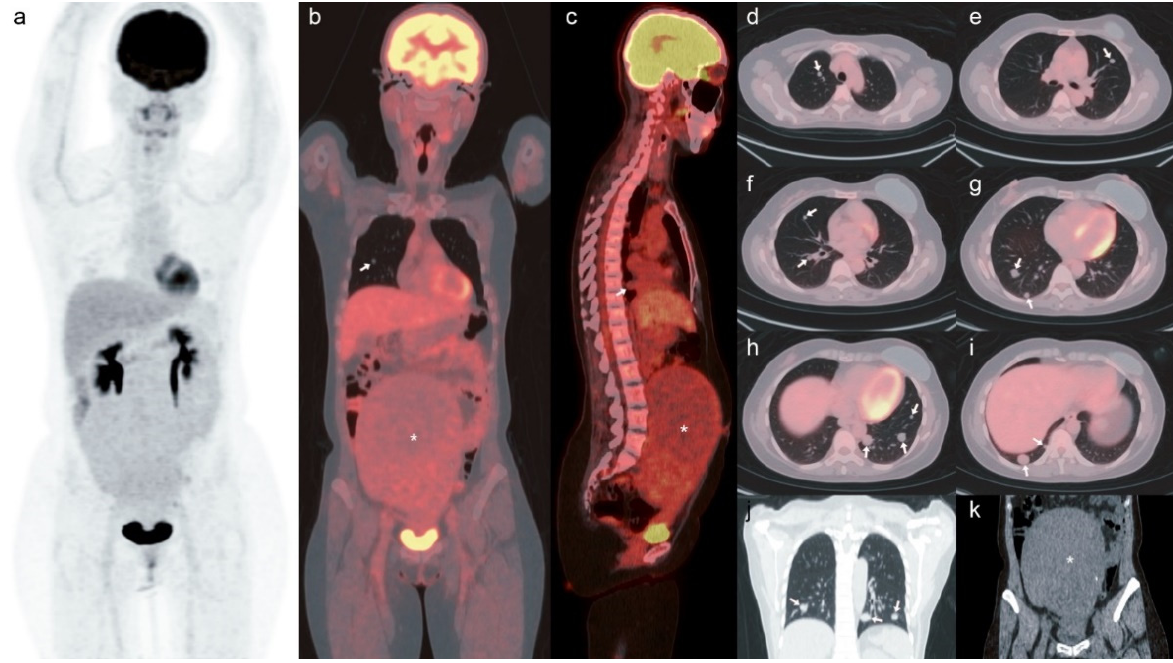
Figure 1. Whole-body [18F]-FDG PET/CT scan. The ( a ) maximum intensity projection image and the ( b ) coronal view, ( c ) sagittal view, ( d – i ) axial view of fused PET/CT showed faint and non-FDG avid nodules in the lungs (shown by arrows). ( j ) Coronal view of chest part, attenuation correction CT revealed multiple nodules (shown by arrows) with maximum size of 1.7 cm over the right lower lobe, and maximum standardized uptake value (SUVmax) of 1.3. ( b , c ) and ( k ) Coronal view of abdominal part, attenuation correction CT showed a huge mass about 19 × 16 cm 2 in size arising from uterus with calcified spots occupying the abdominal cavity depicting mild FDG uptake, SUVmax 2.2 (shown by asterisk). Video-assisted thoracic surgery with a wedge resection of the right lower lobe was performed for pathological confirmation, which revealed one whitish firm solid tumor measuring 1.5 × 1.5 × 1.5 cm 3 in size (Figure 2). Microscopically (Figure 3), the sections showed pictures of leiomyoma of the pulmonary tissue, characterized by a well-defined nodular lesion composed of smooth muscle proliferation. Immunohistochemistry (IHC) stains showed positive expressions for alpha-smooth actin, caldesmon, ER and PR, negative expressions for proto-oncogene c-kit (CD117) and paired box gene 8 (PAX-8). Positive expression for thyroid transcription factor-1 (TTF-1) was noted only on pneumocytes. The final diagnosis was uterine leiomyoma with pulmonary